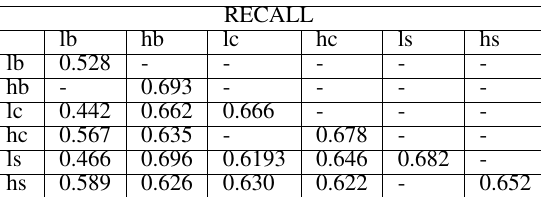
Table 6. Precision, recall and F-score values when using images cropped by 50 % and 90 %